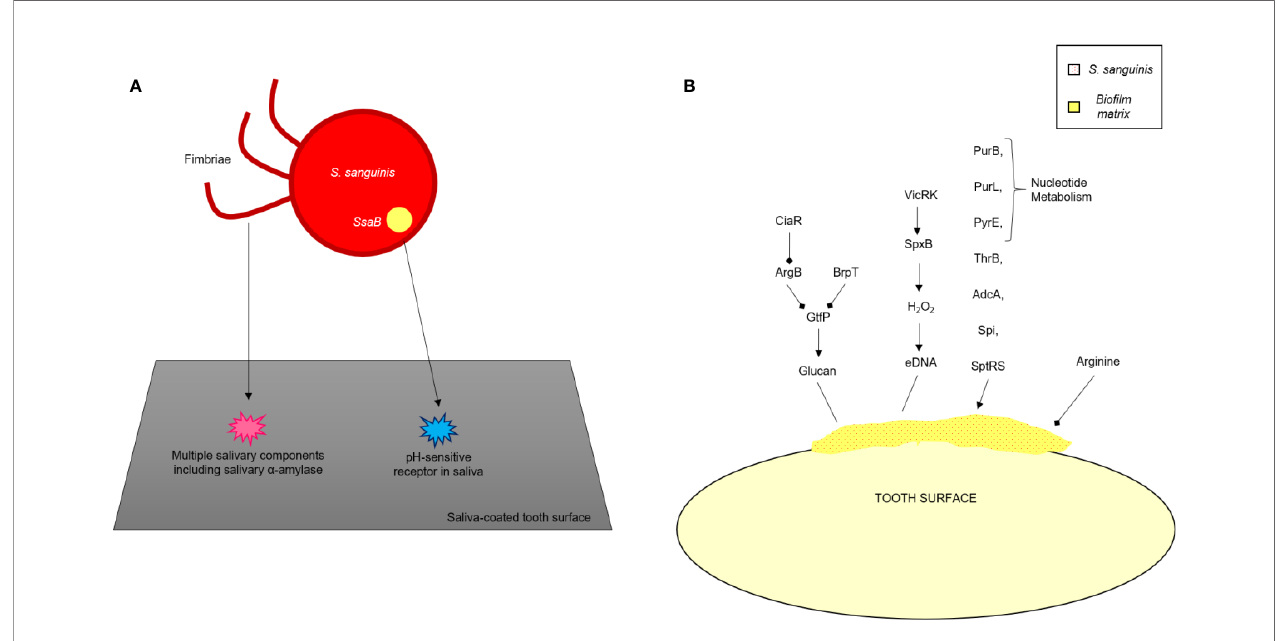
FIGURE 4 | Mechanism of formation of bio fi lm by S.